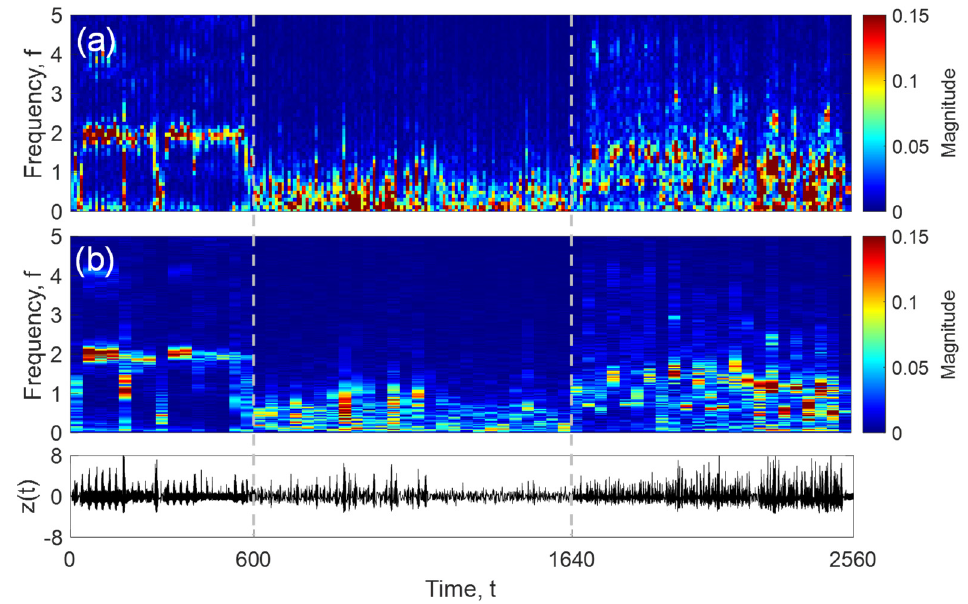
Figure 9. Short-time Fourier transform applied to the measured time history z ( t ) with two window lengths (CH6 record, outer rim): ( a ) T w = 10 s and ( b ) T w = 40